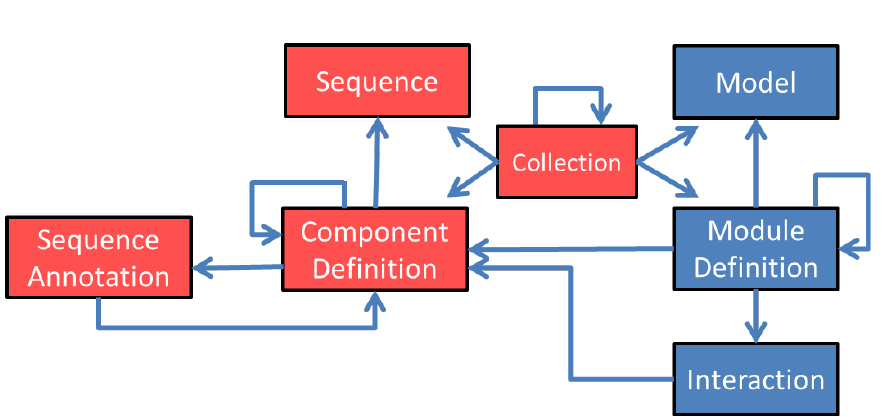
Figure 2: Main classes of information represented by the SBOL standard, and their relationships. Red boxes are classes from the SBOL 1.1 that focused on structure, whereas blue classes are some of the new classes that support the functional aspects of designs.